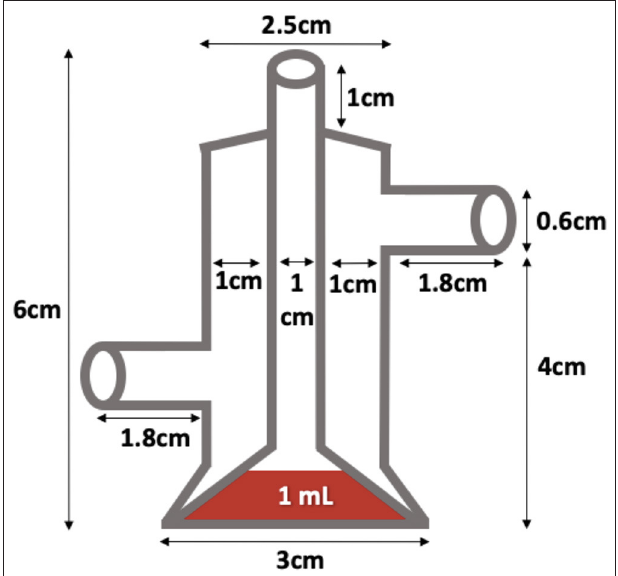
FIGURE 1 | Homemade feeder used in this